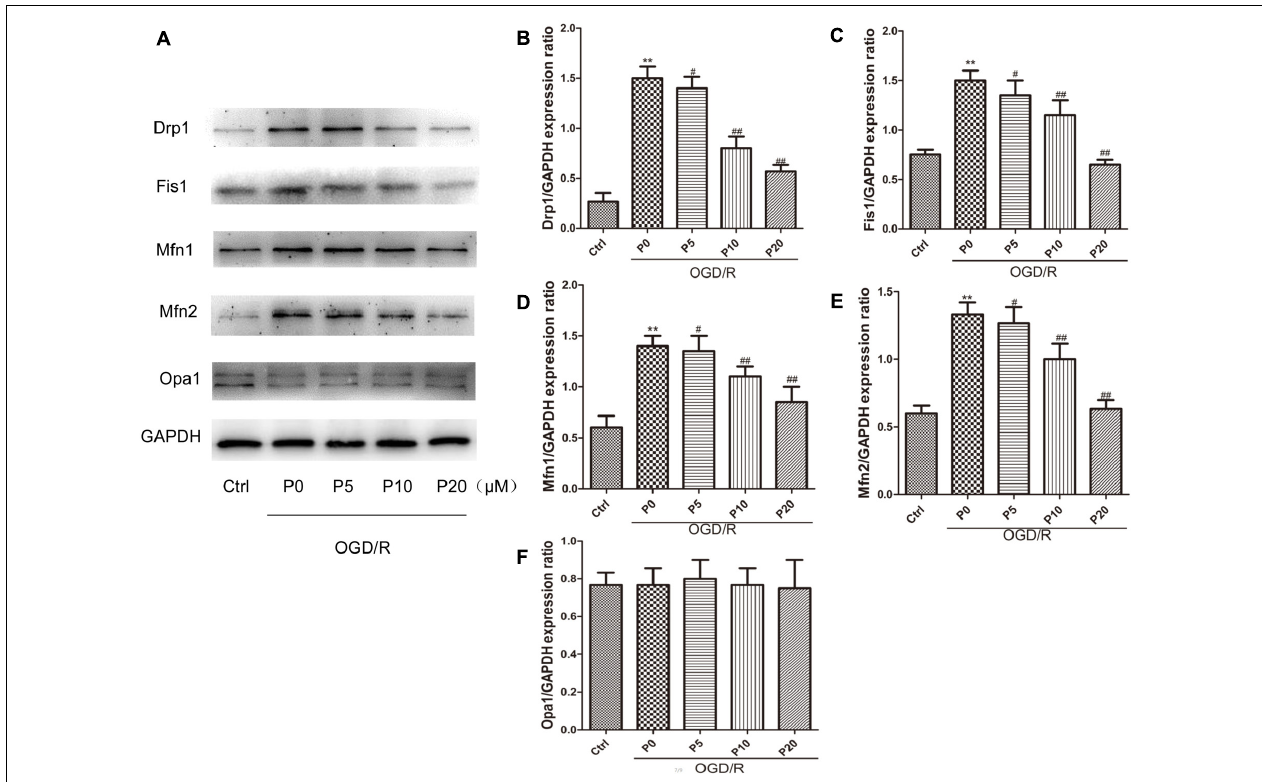
FIGURE 4 | Propofol inhibited high expression of some mitochondrial dynamin family proteins induced by OGD/R in H9c2 cells. (A) Representative bands of Drp1, Fis1, Mfn1, Mfn2 and Opa1 by western blotting. (B–E) With the increase of propofol concentration (5, 10, 20 µ M), the levels of Drp1, Fis1, Mfn1 and Mfn2 protein were significantly decreased during OGD/R injury. (F) However, there was no significant difference in the levels of Opa1 between control group and OGD/R group with or without propofol. The data are presented as the mean ± SD of at least three independent experiments. ∗∗ P < 0.01 versus control, # P < 0.05, ## P < 0.01 versus OGD/R group without